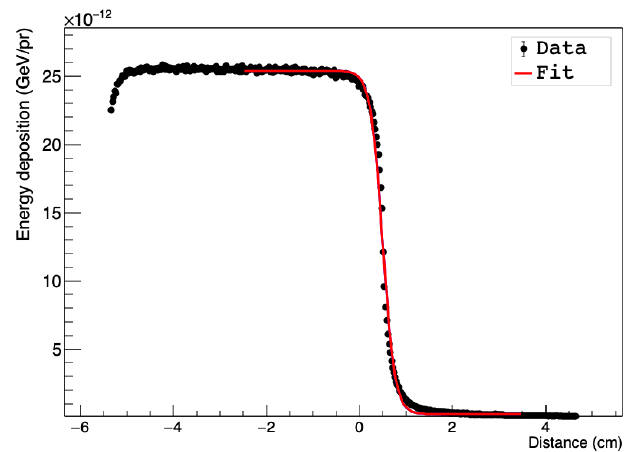
Figure 15. Simulated ESF for the edge projection fitted by a logistic function. The results were ob- tained for a detector-source distance of 230 cm, a beam aperture of 1 cm and 40 kV X-rays. The error bars are smaller than the data